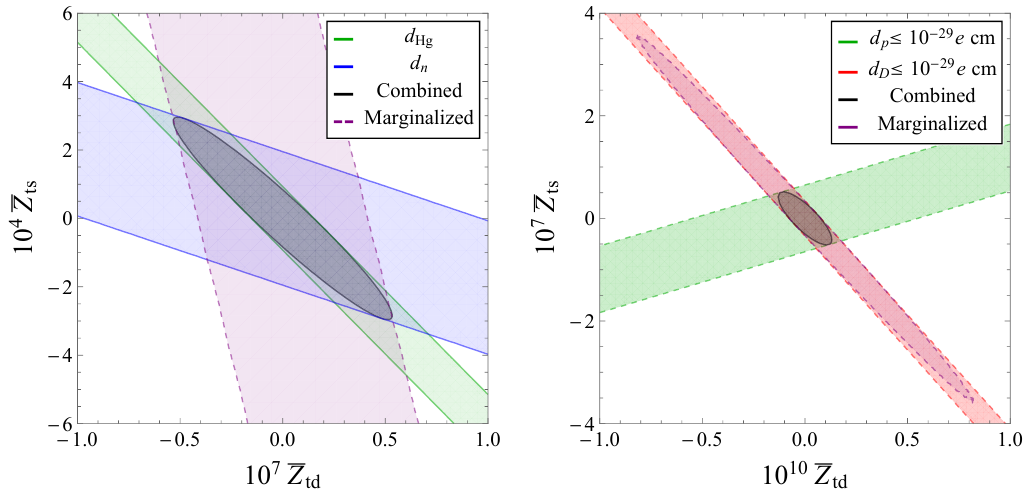
Figure 10 . Left panel: constraints from various EDM experiments in the (cid:22) Z td - (cid:22) Z ts plane. The dark ellipse is the combined allowed region, while the purple dashed band illustrates the allowed region when we also assume a nonzero Z tb coupling. Right panel: constraints using expected sensitivities of future proton and deuteron EDM